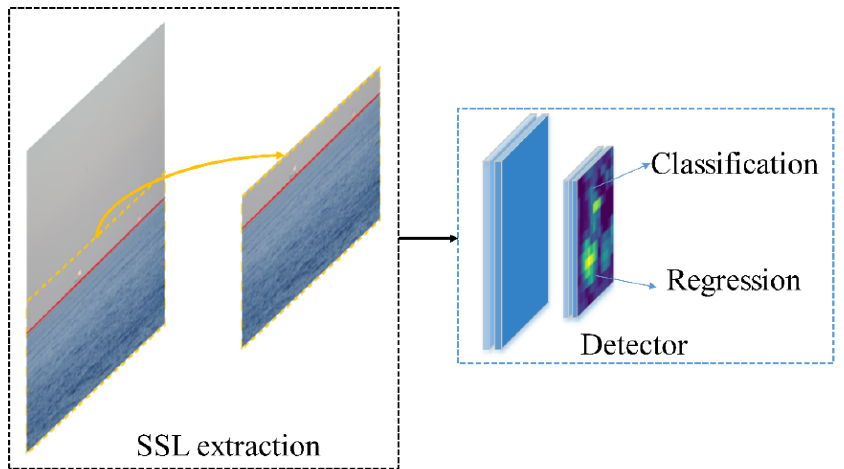
Figure 7. Before sending an image to the detector, SSL detection can reduce the search for candidate regions.